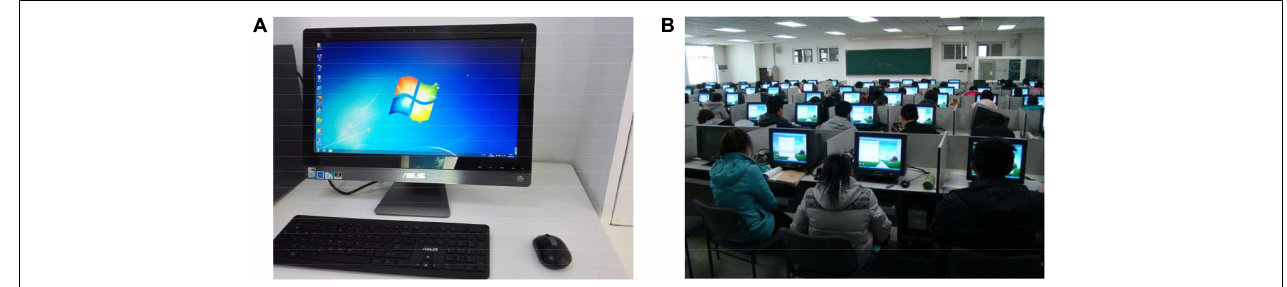
FIGURE 1 | Specific environmental conditions ( A: A single computer used in the student simulation experiment; B: Scene of the student simulation experiment). TABLE 2 | Overall LISREL model analysis result. Evaluation